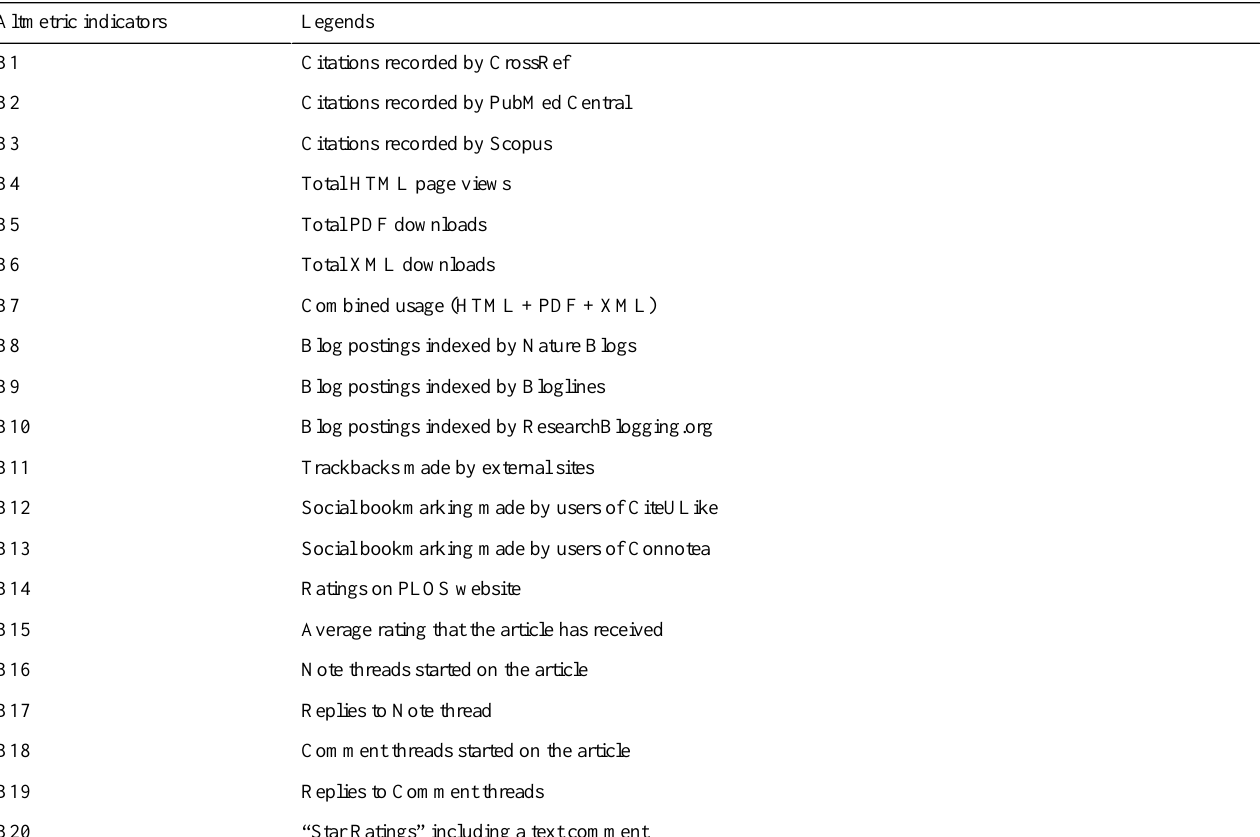
Table 2. Legends for B1 to B20. LegendsAltmetric